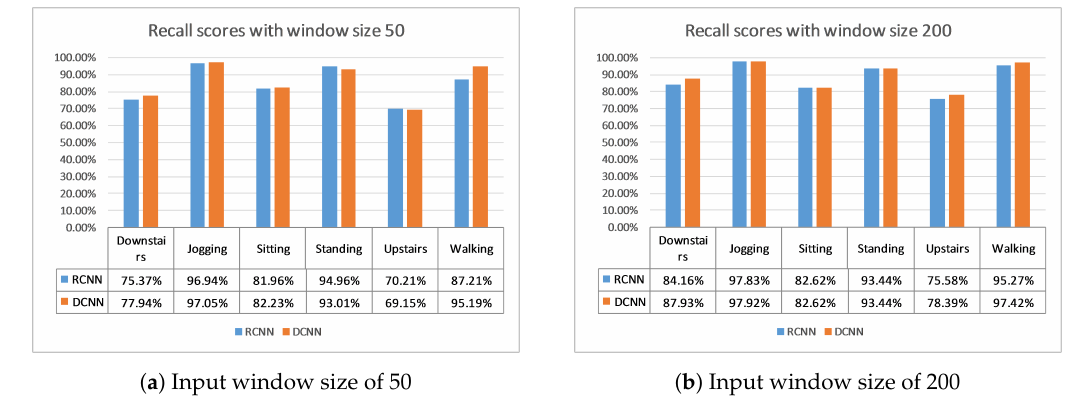
Figure 3. Recall scores on the original train/test split of the WISDM dataset.